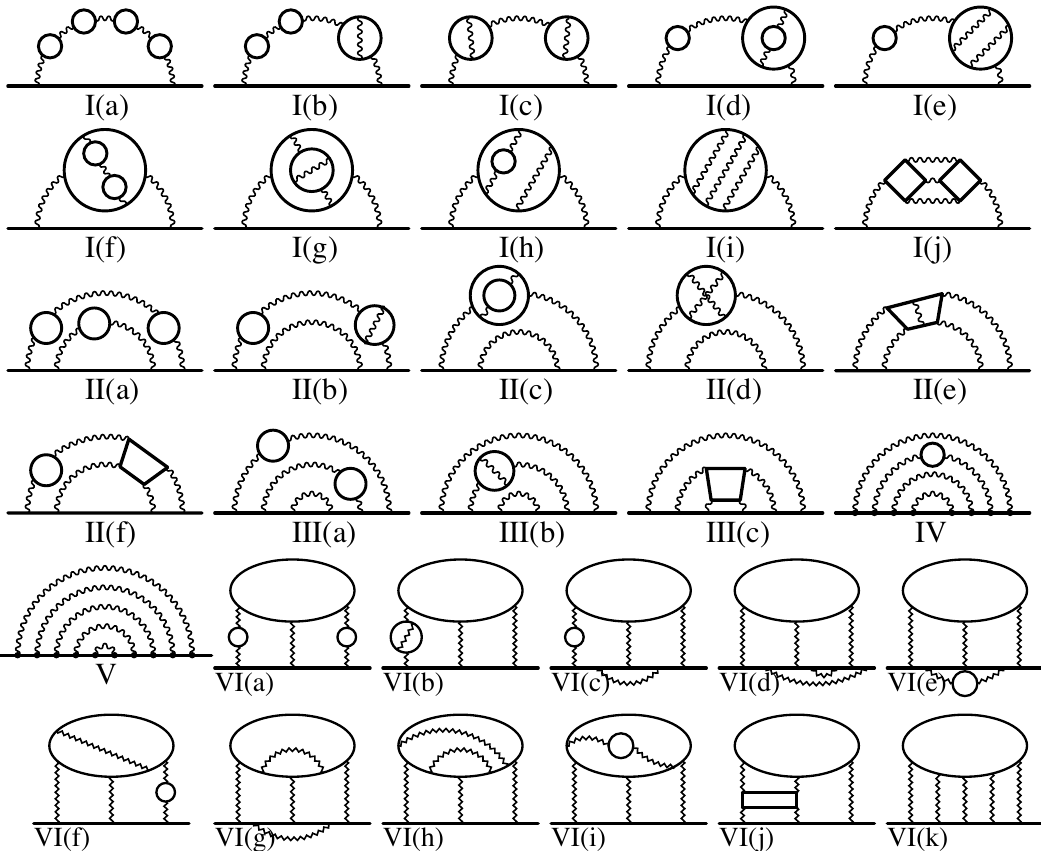
Figure 5. Tenth-order vertex diagrams. There are 12,672 diagrams in total, and they are divided into 32 gauge-invariant subsets over six super sets. Typical diagrams of each subsets are shown as I ( a – j ), II ( a – f ), III ( a – c ), IV , V , and VI ( a – k ). There are Set I 208 diagrams (I(a) 1, I(b) 9, I(c) 9, I(d) 6, I(e) 30, I(f) 3, I(g) 9, I(h) 30, I(i) 105, I(j) 6), Set II 600 diagrams (II(a) 24, II(b) 108, II(c) 36, II(d) 180, II(e) 180, II(f) 72), Set III 1140 diagrams (III(a) 300, III(b) 450, III(c) 390), Set IV 2072 diagrams, Set V 6354 diagrams, Set VI 2298 diagrams (VI(a) 36, VI(b) 54, VI(c) 144, VI(d) 492, VI(e) 48, VI(f) 180, VI(g) 480, VI(h) 630, VI(i) 60, VI(j) 54, VI(k) 120). The straight and wavy lines represent electron and photon propagators, respectively. The external photon vertex is omitted for simplicity and can be attached to one of the electron propagators of the bottom straight line in super sets I–V or the large ellipse in super set VI. Reprinted from